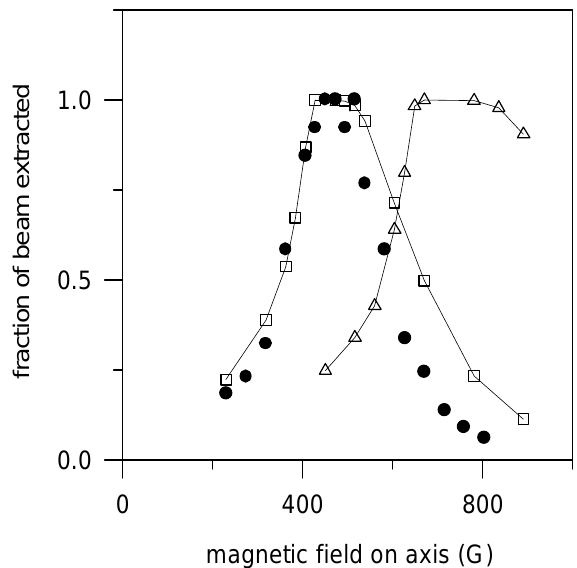
FIG. 7. Fraction of the electron beam charge which is ex- tracted from the drive gun, as a function of the solenoidal field. The points represented by circles correspond to experimental data; the squares and triangles correspond to numerical simula- tion results using 55 and 92 MV (cid:121) m, respectively.